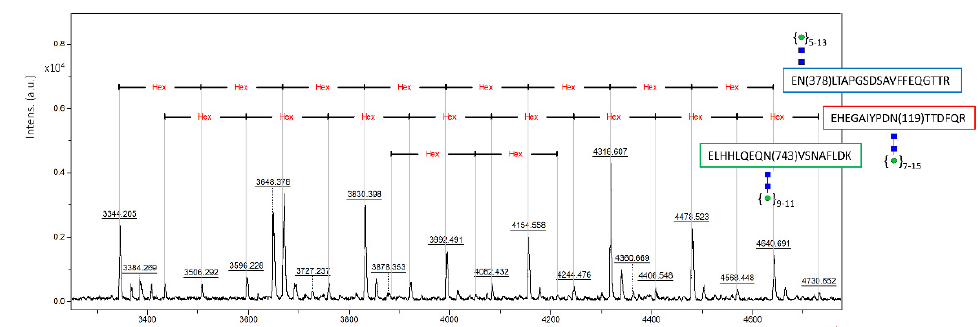
Figure 4. MALDI TOF spectrum of recombinant CP tryptic glycopeptides including their peptide backbones and glycans attached.